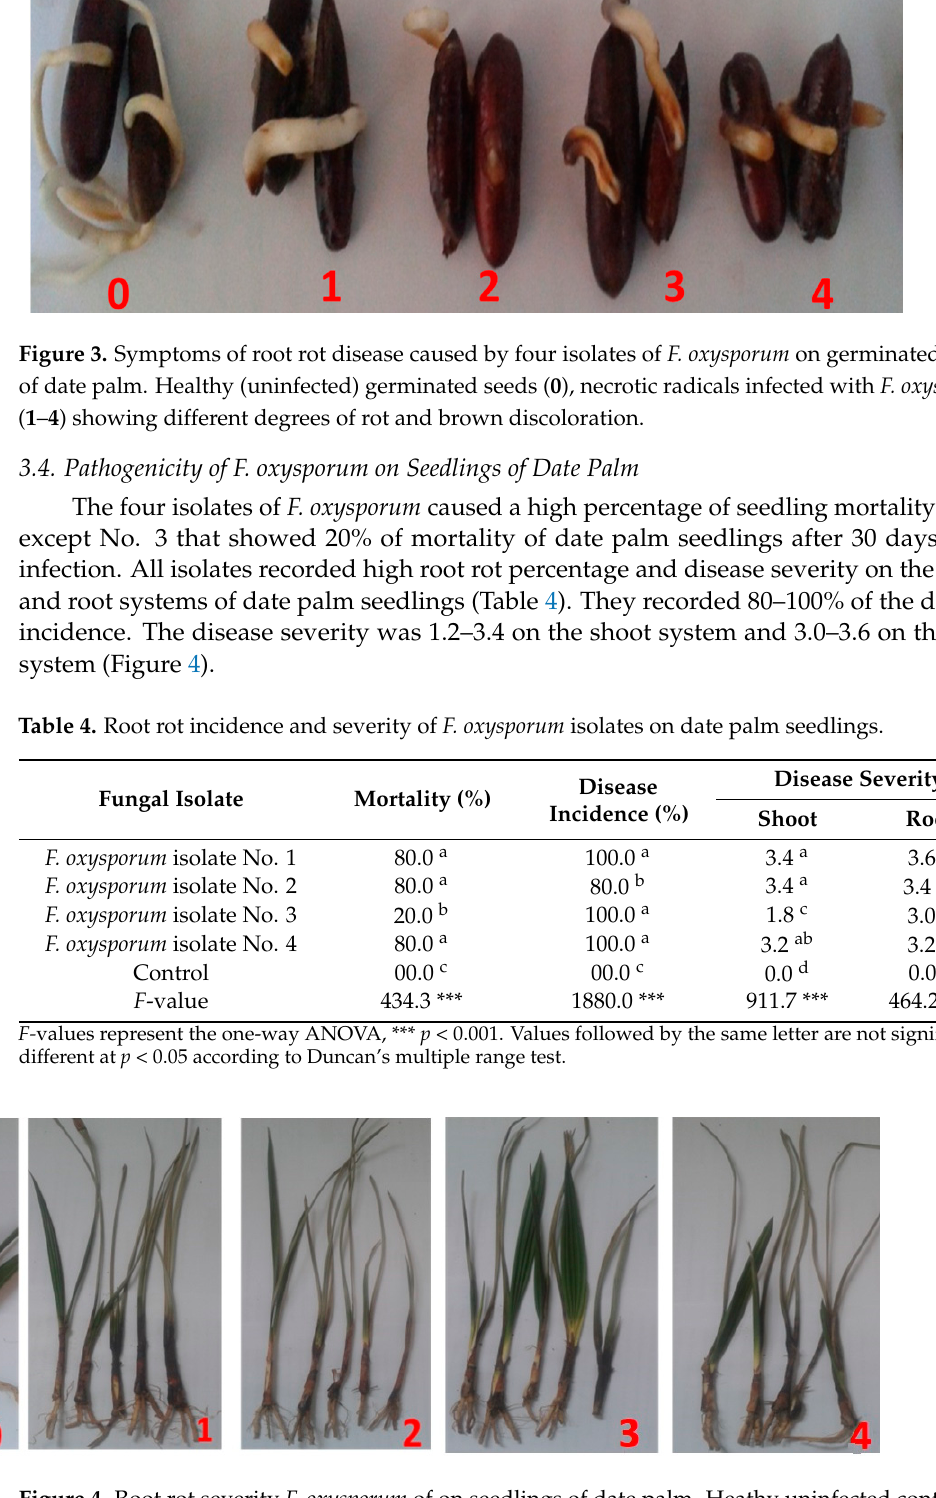
Figure 4. Root rot severity F. oxysporum of on seedlings of date palm. Heathy uninfected control ( 0 ), and infected seedling with different isolates ( 1 – 4 ).